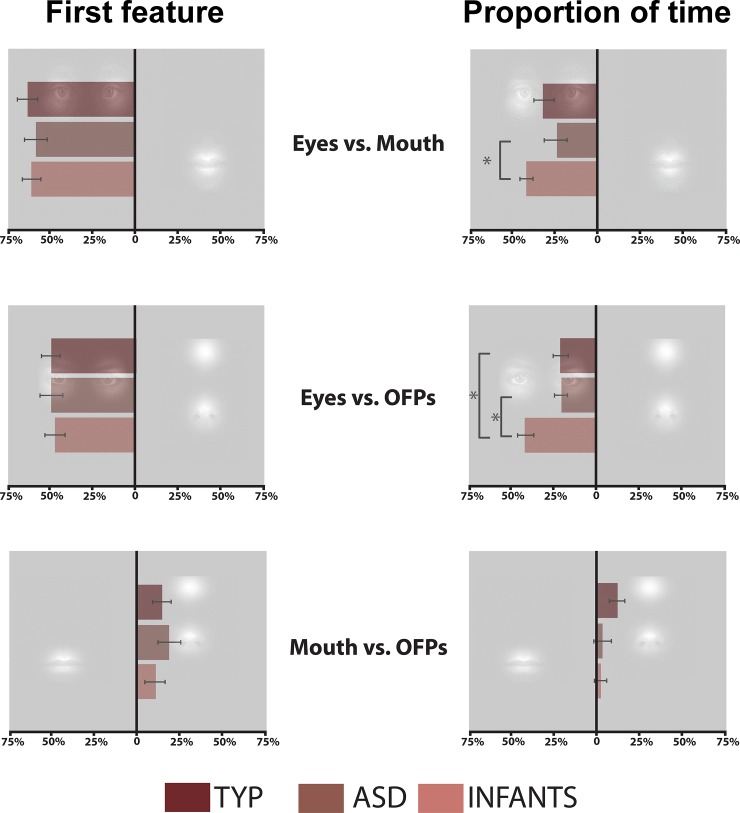
Results.a) Difference scores (in percent of trials) for which feature of a pair was looked at first. Difference scores were calculated by subtracting the percent of trials during which one feature was looked at first from the percent of trials during which the competing feature was looked at first. The direction of the bar indicates which feature of the pair was more frequently looked at first. b) Difference scores (in percent of total trial time) for time spent on competing features. Difference scores were calculated by subtracting the percent of the total trial time spent looking at one feature from the percent of total trial time spent looking at the competing feature. The direction of the bar indicates which feature of the pair had a higher dwell time measured as a percent of total trial time. Error bars represent +/- 1 standard error.